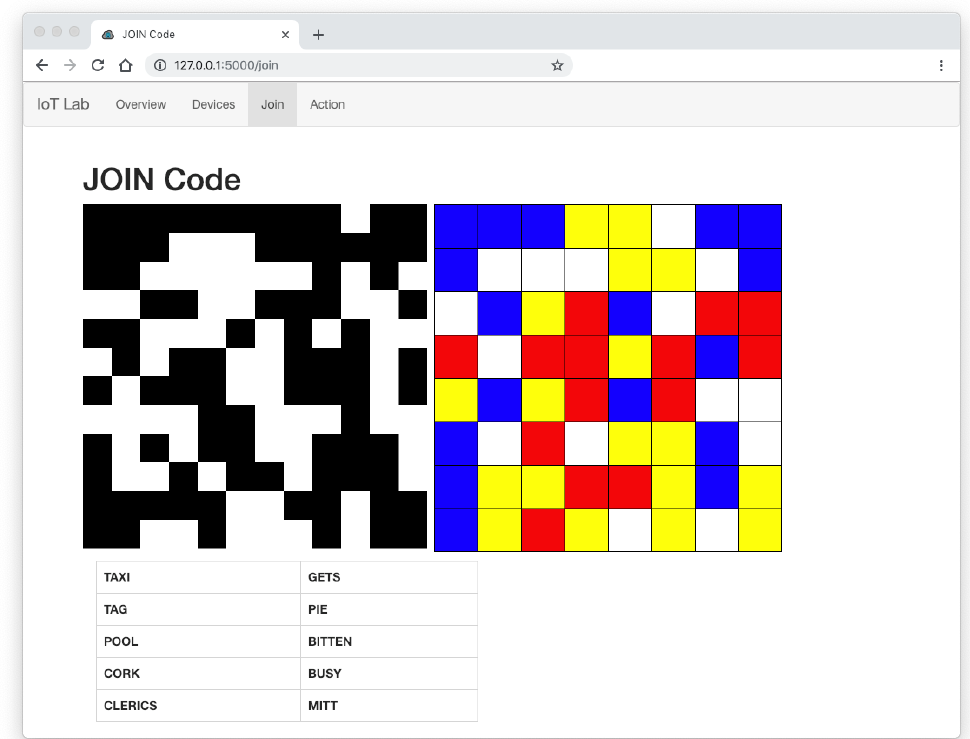
Figure 4. An example web-based C2 interface for an IoT system, showing an example display depicting a range of human-comparable display